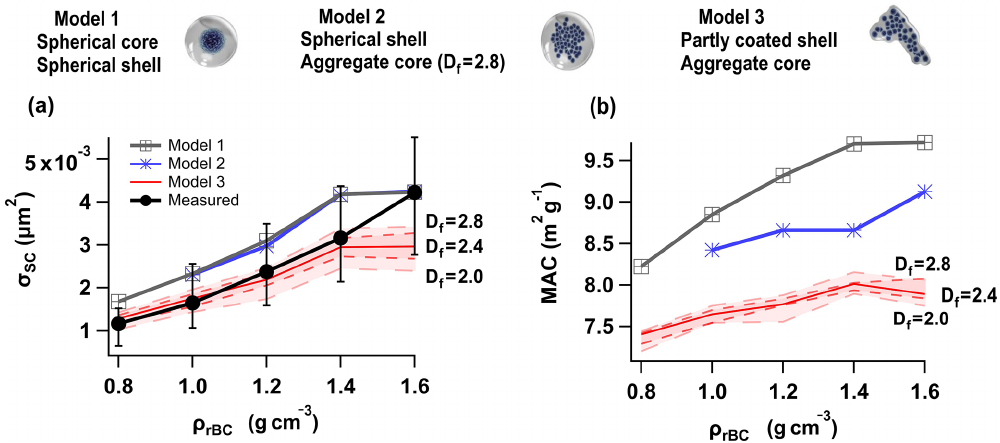
Figure 7. (a) The scattering cross section of BC-containing particles at the 1064nm wavelength predicted by different models and measured by the SP2 under different effective densities. (b) The mass absorption cross section at the 532nm wavelength predicted by different models under different effective densities. Model 3 was used with various assumptions of the core fractal dimension ( D f = 2 . 0, 2.2, 2.4, 2.6, and 2.8) as denoted in the